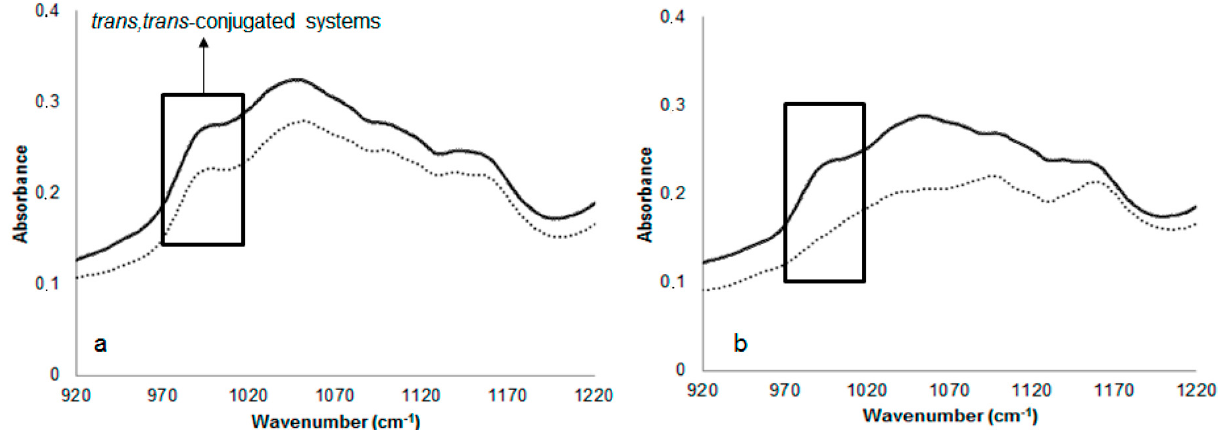
Figure 5. ATR-FTIR spectra zoomed region at 1220–920 cm − 1 of fried ( a ) and roasted ( b ) sunflower seed samples at zero ( Figure 2. Thermogravimetric ( ) profiles and first derivative curves ( ) at day 0 Figure 4. ATR-FTIR spectra of roasted ( a ) and fried ( b ) sunflower seed samples at zero ( ), three ( ), five ( obtained for roasted ( a ) and fried ( b ) sunflower seed samples. ), and 10 ( ) days of oxidative treatment at 100 °C.